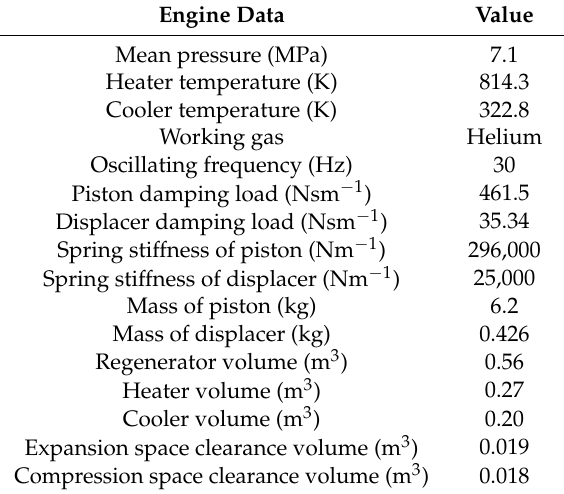
Table 1. Parameters of the RE-1000 Sunpower FPSE used in this study